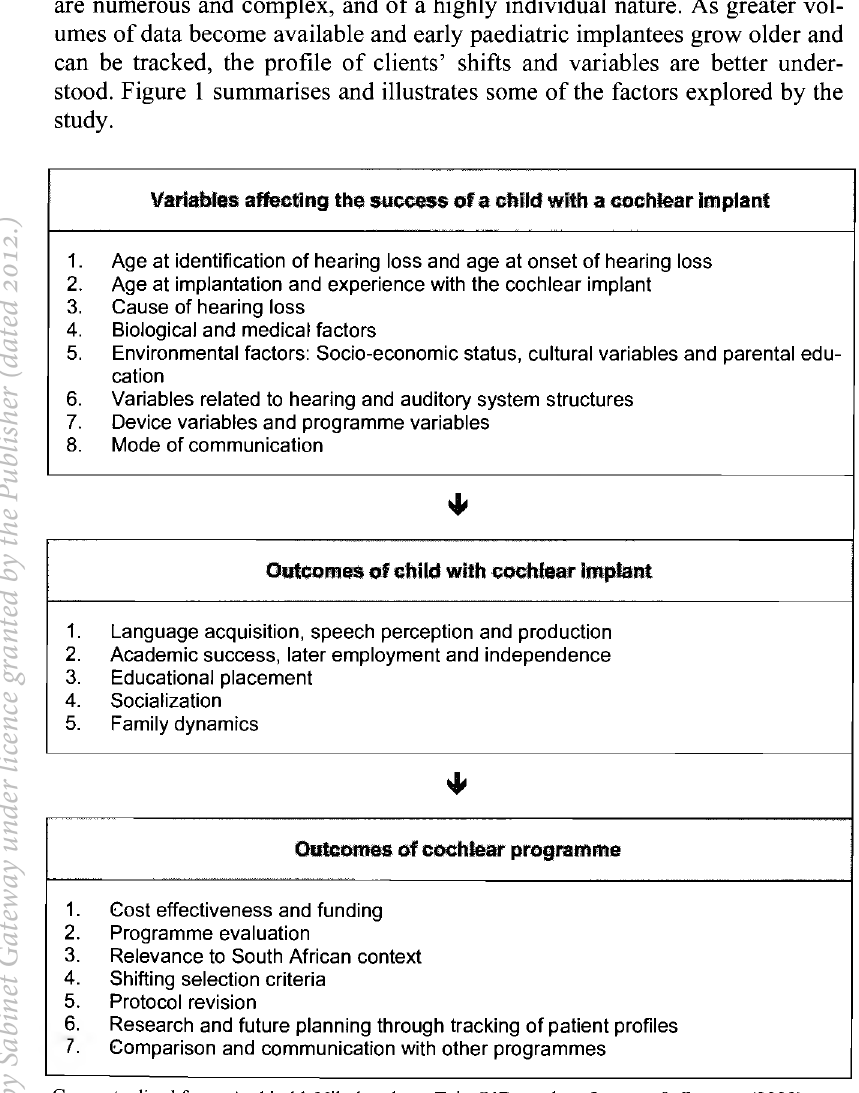
Figure 1: Summary of factors affecting client and programme